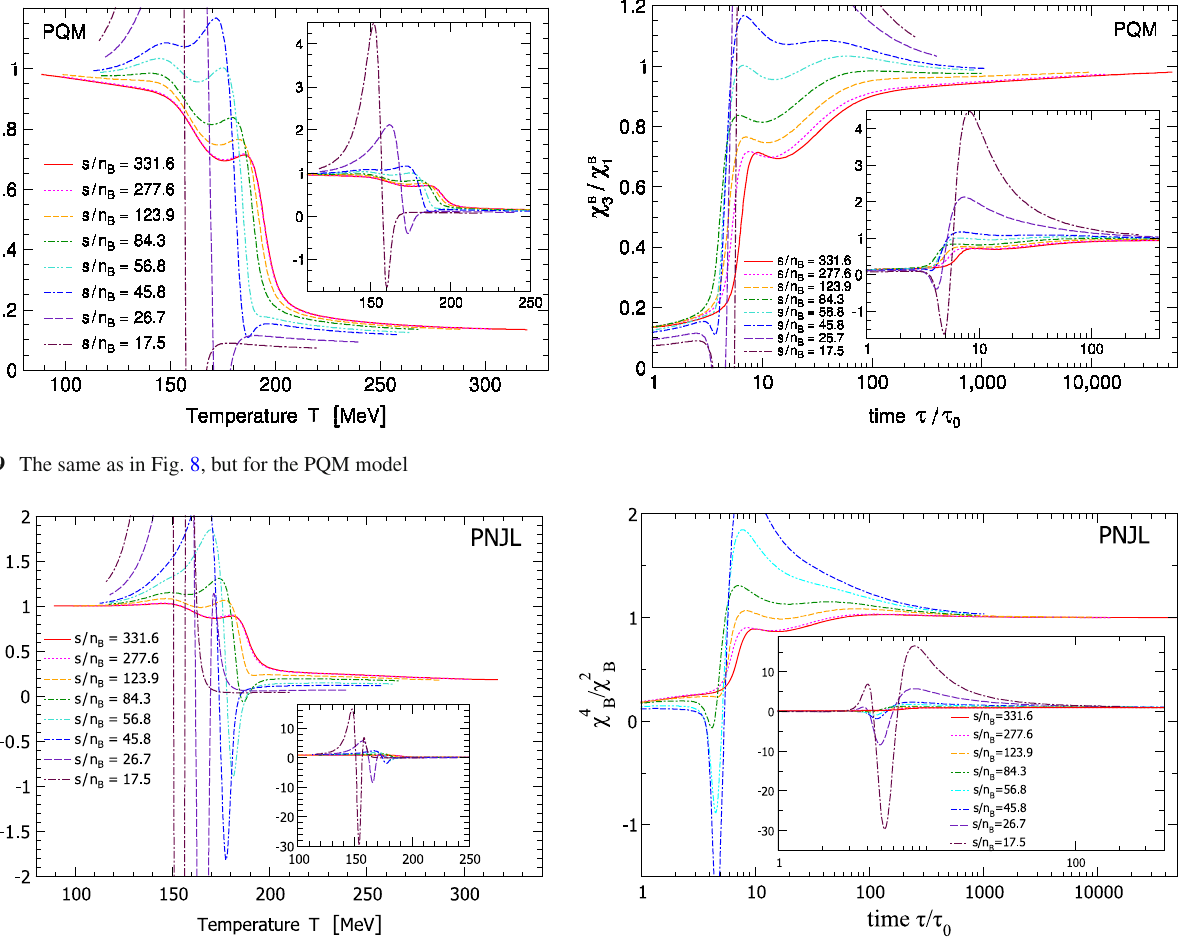
Fig. 10 PNJL results for the normalized kurtosis of the baryon-number distribution plotted as a function of temperature (left panel) and time τ (right panel) along the isentropic trajectories shown in Fig. 1. The evolution always starts at time τ 0 = 1 fm/c, corresponding to the entropy densities